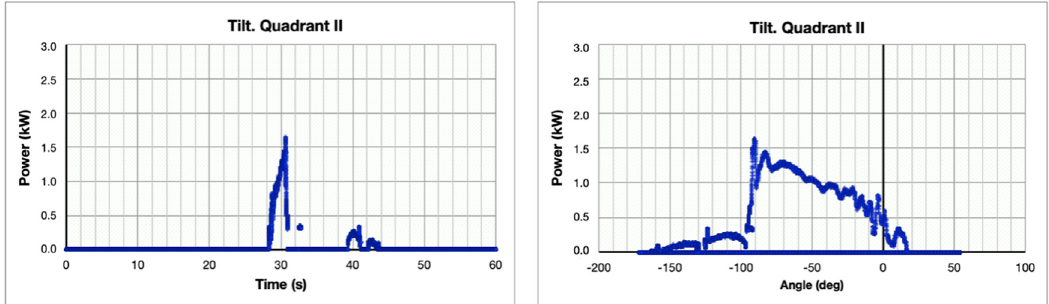
Figure 16. Quadrant operation of the tilt actuator.